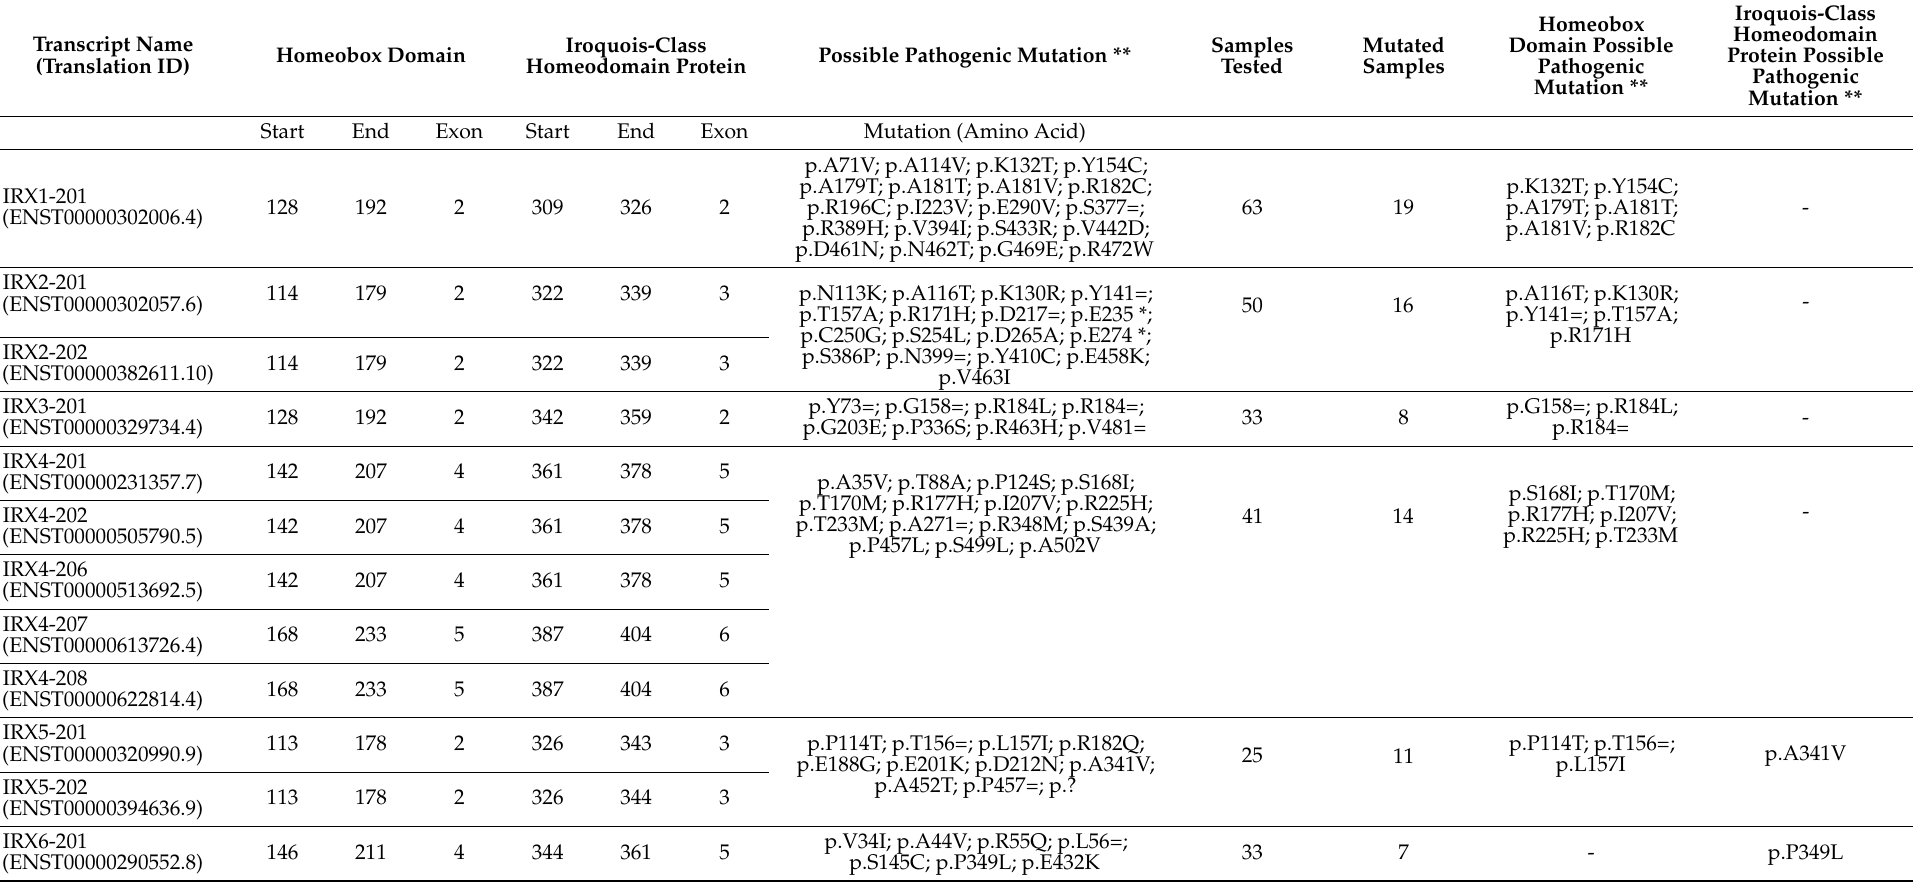
Table 2. Characterization of potentially pathogenic somatic mutations related to Iroquois genes in GC